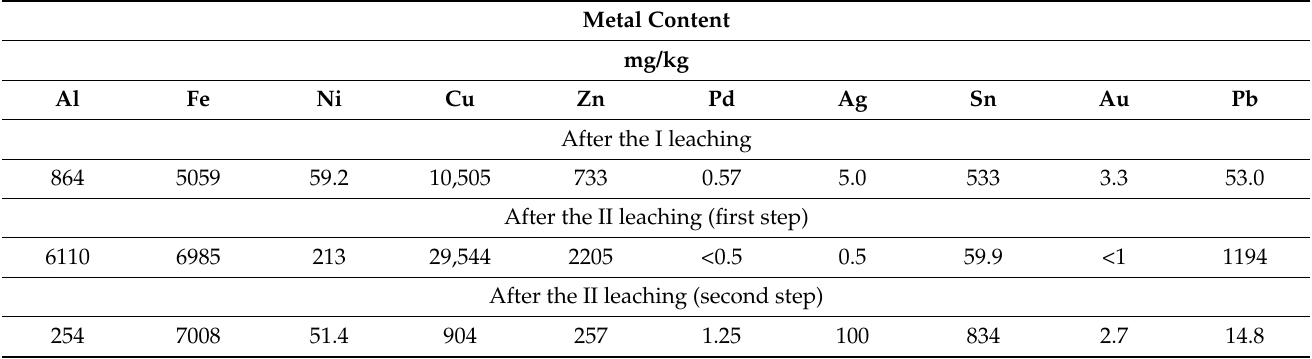
Table 2. Metal content in the liquid phases after leaching processes (ICP-MS